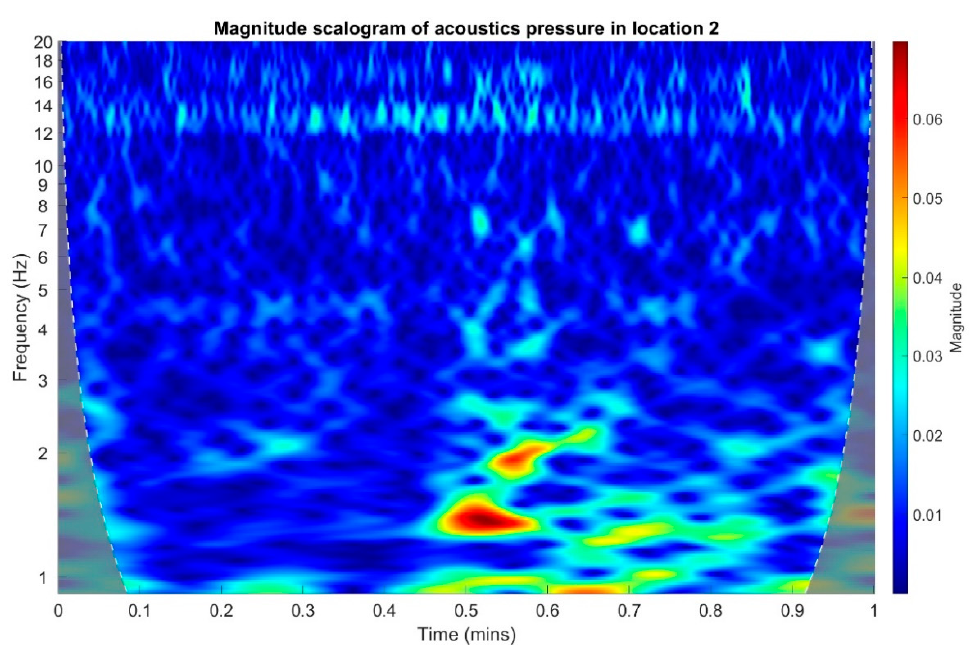
Figure 21. Magnitude scalogram of acoustic pressure in location 2.